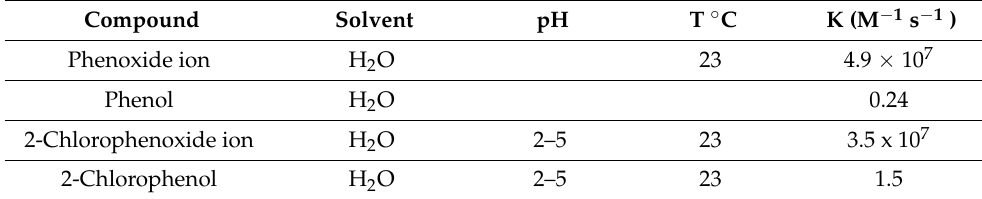
Table 1. Constants determined for ClO 2 reactions with phenols.